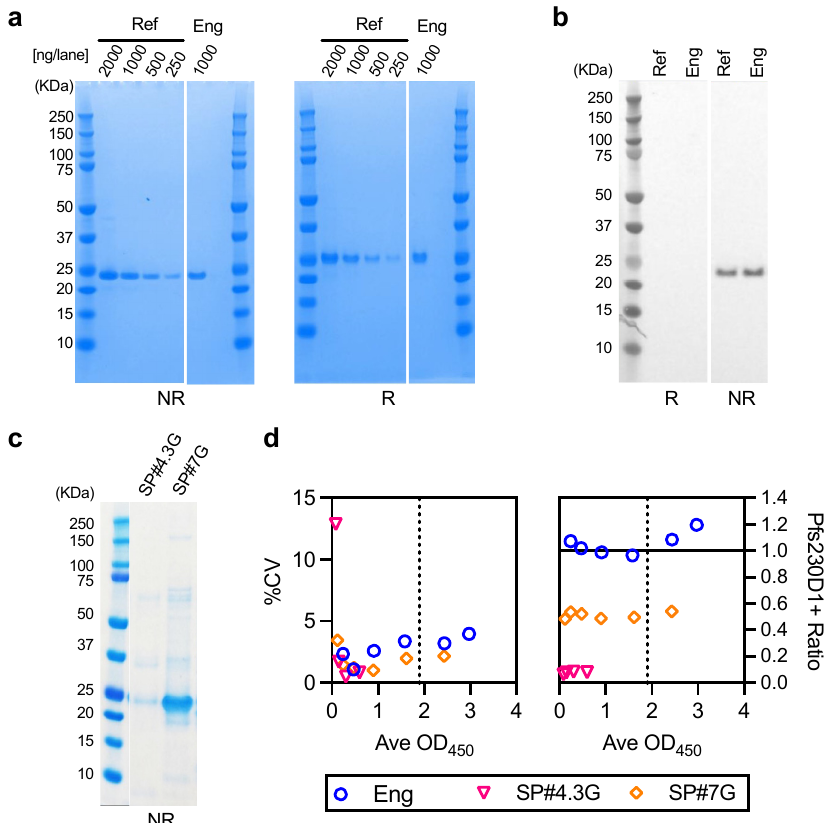
Figure 7. Evaluation for the engineering lot of Pfs230D1+ (Eng). Reference (Ref) and engineering (Eng) lot of Pfs230D1+ proteins were evaluated by SDS-PAGE ( a ) and western blot ( b ) both under reducing (R) and non-reducing (NR) conditions. The western blot was done with H73 mAb. ( c ) two in-processed proteins, SP#4.3G and SP#7G were tested by SDS-PAGE under a non-reducing condition. Uncropped SDS-PAGE and western blot images are seen in Figure S3. ( d ) AIA was performed with Eng, SP#4.3G and SP#7G proteins. Since OD 450 values for SP#4.3G did not reach to the midpoint of standard sigmoid curve (vertical dotted line, OD 450 = 1.9), %CV and Pfs230D1+ Ratio at all 6 dilutions for each test sample are shown.